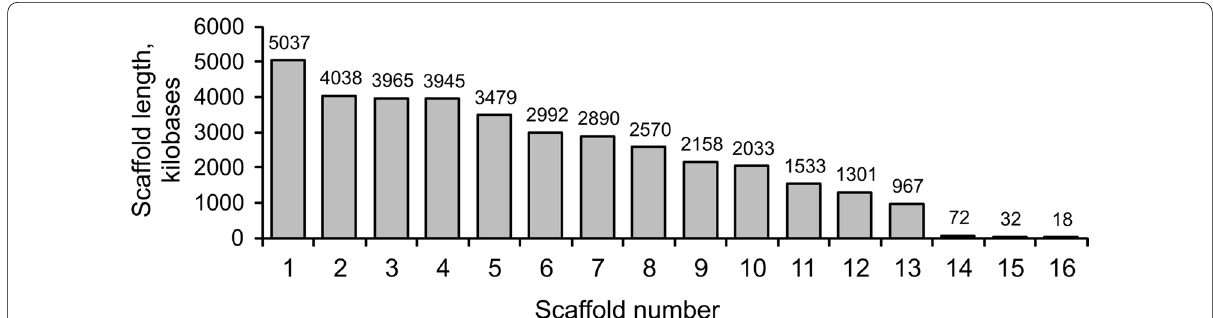
Fig. 3 The lengths of scaffolds in the Microdochium nivale genome